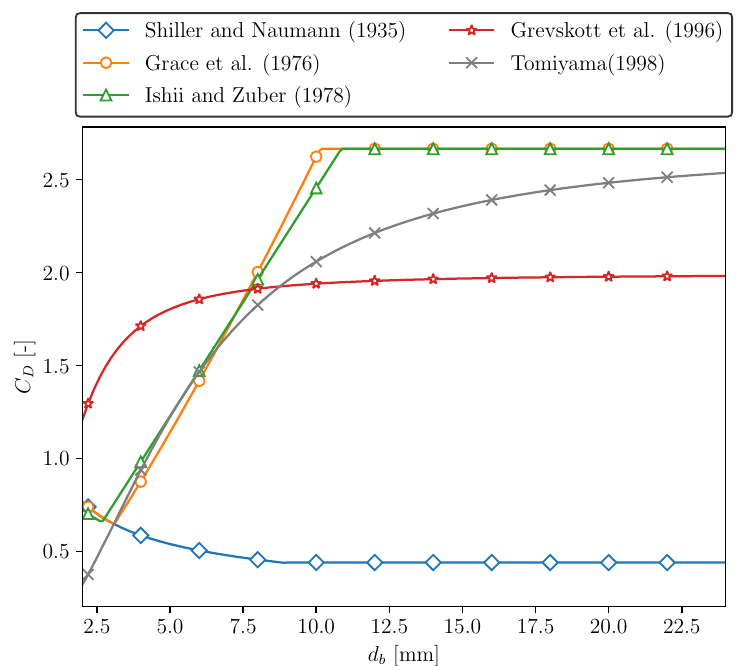
(cid:126) u (cid:126) u = 0.1 m/s L | G − |